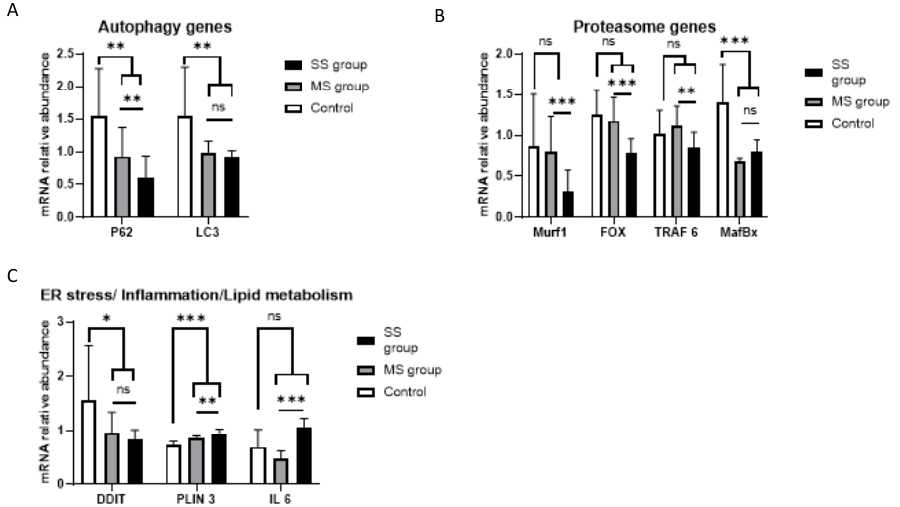
Figure 6. mRNA expression of human primary myotubes incubated for 48 h with a mix of sera from either control patients (control), HNC patients with severe sarcopenia (SS group), or HNC patients with mild sarcopenia (MS). For each condition, n = 2 replicates. Fold change in mRNA expression of human-differentiated myotubes incubated for 48 h with a mix of sera from either control patients (control), HNC patients with severe sarcopenia (SS group) or HNC patients with mild sarcopenia (MS). Gene expression in each condition was normalized to GAPDH expression. *: p < 0.05, **: p < 0.01, and ***: p < 0.001. ( A ) Genes related to the autophagy process. ( B ) Genes related to proteasomal activity. ( C ) Genes related to lipid metabolism, endoplasmic reticulum, or inflammatory